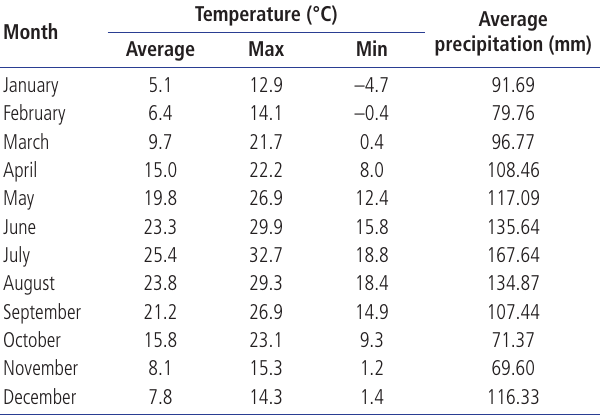
Table 1. Basic monthly meteorological information for North